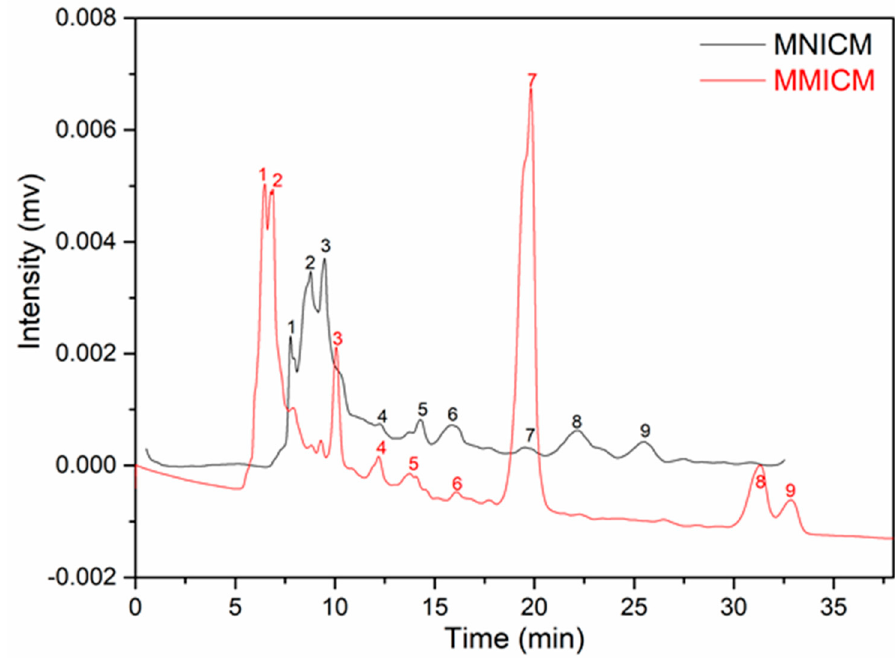
Figure 6. Extraction chromatograms of the environmental water using the MMICM and MNICM. (Column: C18 column, mobile phase: acetonitrile: water (= 70:30, v / v ), flow rate: 1.0 mL · min − 1 , UV: 254 nm, injection: 20 µ L).